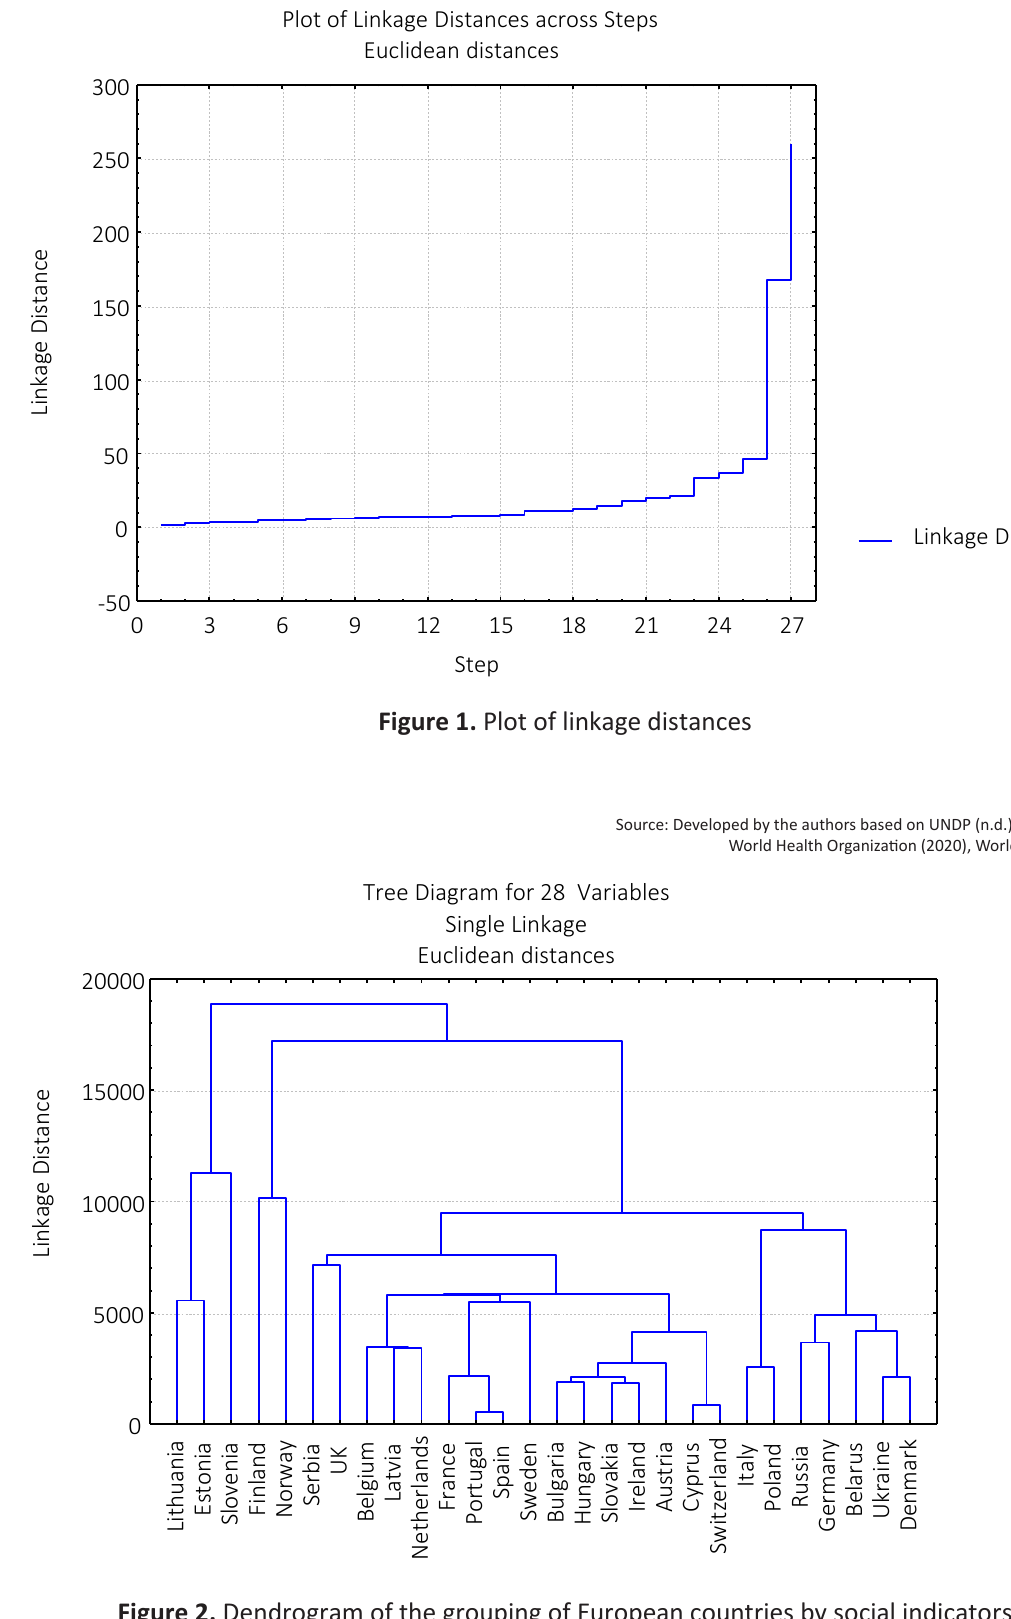
Figure 2. Dendrogram of the grouping of European countries by social indicators of healthcare system